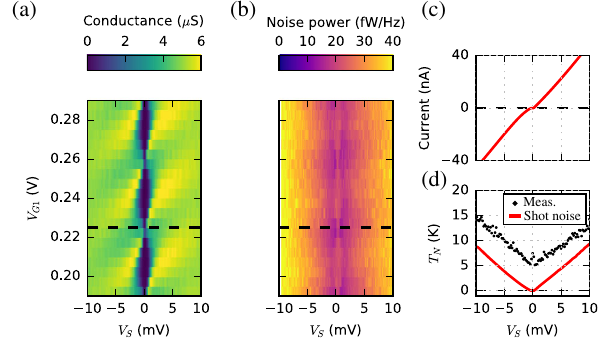
FIG. 6. Measured noise levels. (a) dc conductance of the SETas a function of dc bias V and gate voltage V showing the S G 1 Coulomb diamond structure. (b) Simultaneously measured power spectral density output from the rf measurement chain at 222.3 MHz as a function of V and V . At low bias, noise S G 1 from the preamplifier dominates and is modulated by the conductance of the SET. At high bias, the noise level is linear with the current in the SET, consistent with SET shot noise. (c) dc current through the SET as a function of V at the black dashed S ¼ 0 . 225 V). (d) Measured noise output at line in (a) and (b) ( V G 1 the dashed line in (b), scaled to an equivalent noise temperature referred to the input of the preamplifier (black). The estimated shot-noise contribution to this noise is plotted as the red